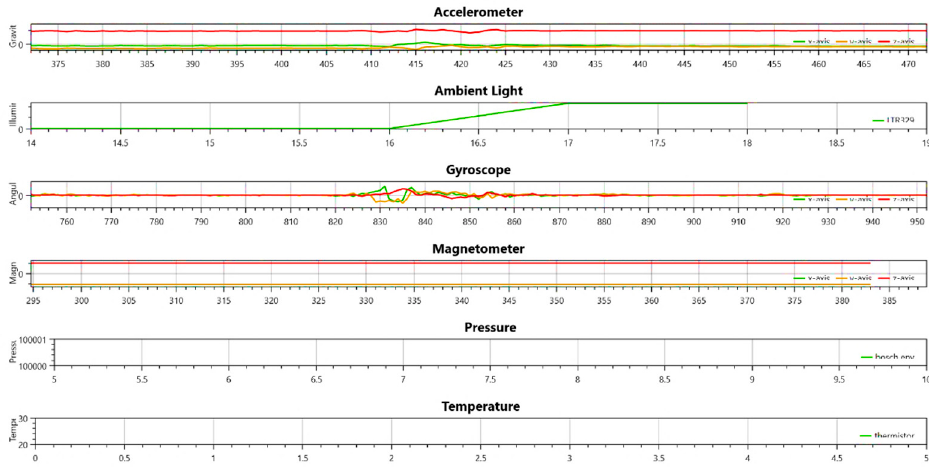
Figure 2. Real-time data collection from the Sleeve Sensor Research Kit from Mbient Labs during one of the experiments.